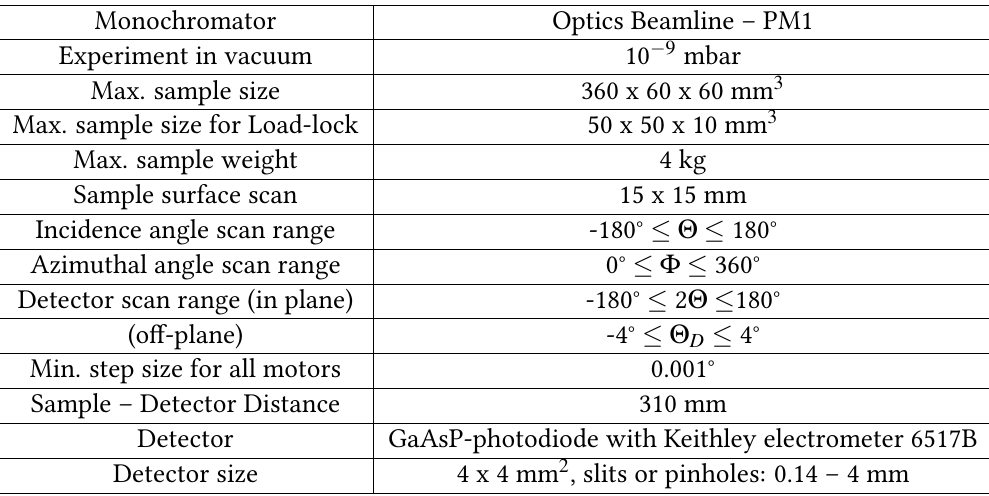
Table 3: Performance data of the